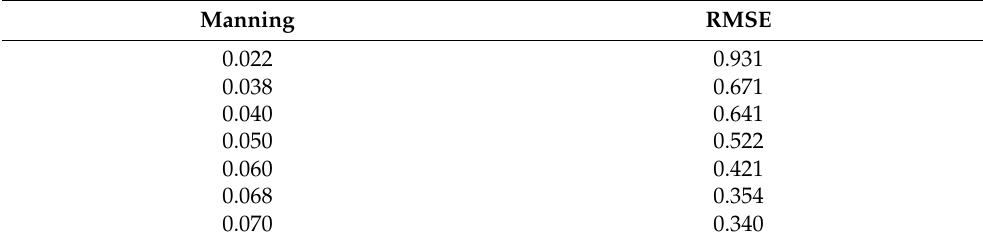
Figure 11. Comparison of simulated and observed water level values from the static roughness model using several Manning values. Table 2. RMSE values achieved by the different floodplain Manning values of each